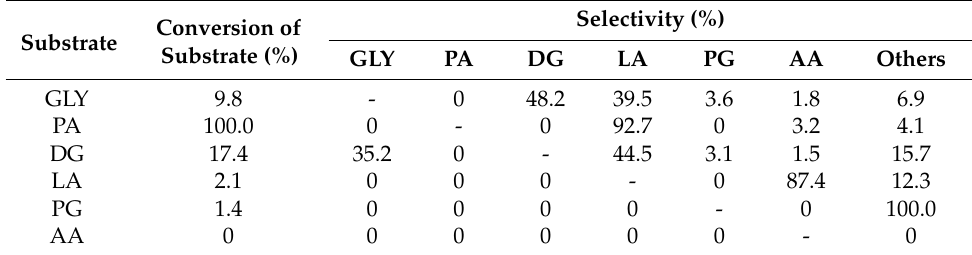
Table 2. The composition of the reaction mixture after the conversion of various substrates in the presence of NaOH. Selectivity (%) Conversion of Substrate Substrate (%) GLY PA DG PG Others GLY